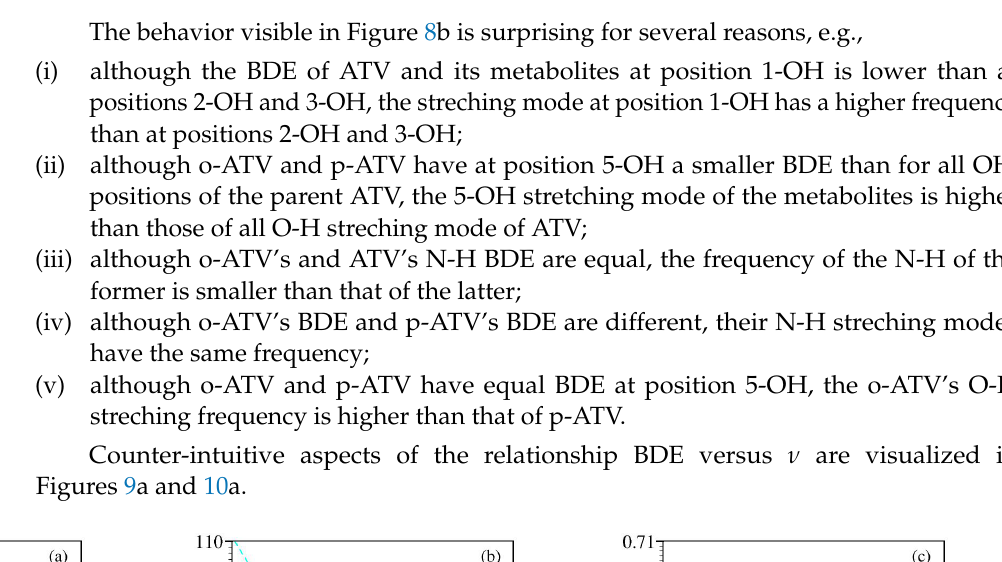
Figure 8. Infrared spectra calculated for ATV, o-OH-AVT, and p-ATV in methanol using Lorentzian convolution of full width at half maximum (FWHM) indicated in the inset: ( a ) in the whole range of frequency and ( b ) in the range where the O-H and N-H stretching modes are active. In all species, stretching modes of 2-OH and 3-OH groups appear as linear and antilinear vibrations rather than separated vibrational modes, and this may indicate that a more adequate optimization of the radicals generated by H-atom abstraction at these positions (which appear almost degenerate energetically, see pertaining BDE values in Table 4) should be done within a multi-reference framework.